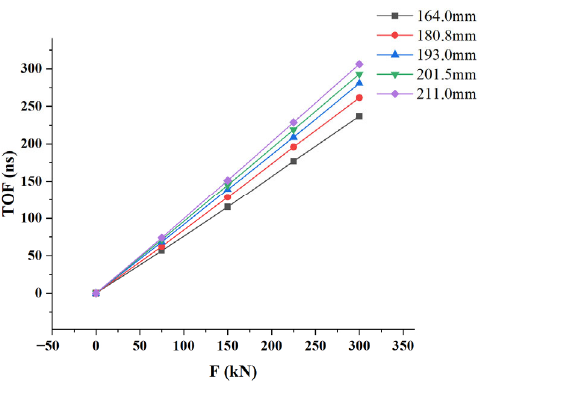
Figure 7. 𝑘 at different clamping lengths for ( a ) M42 bolt; ( b ) M48 bolt. The slope 𝑘 under different clamping lengths showed good linearity with 𝐿 (cid:3030) , which corresponded to the derivation process from Equation (11) to Equation (12), and verified the conclusion of Equation (12), that is, slope 𝑘 is linearly correlated with 𝐿 (cid:3030) . According to Equation (13), 𝛥𝐿 could be calculated for every two sets of calibrations. The average value of 𝛥𝐿 , stored as the calibration parameters of this bolt, and the corresponding 𝑣 (cid:2868) 𝑆 (cid:3032) /2 (cid:4666)𝐸 (cid:2879)(cid:2869) (cid:3398) 𝐶 (cid:3013) (cid:4667) for each clamping length configuration were obtained by Equation (12). The calculation results of 𝛥𝐿 and 𝑣 (cid:2868) 𝑆 (cid:3032) /2 (cid:4666)𝐸 (cid:2879)(cid:2869) (cid:3398) 𝐶 (cid:3013) (cid:4667) are shown in Table 2.